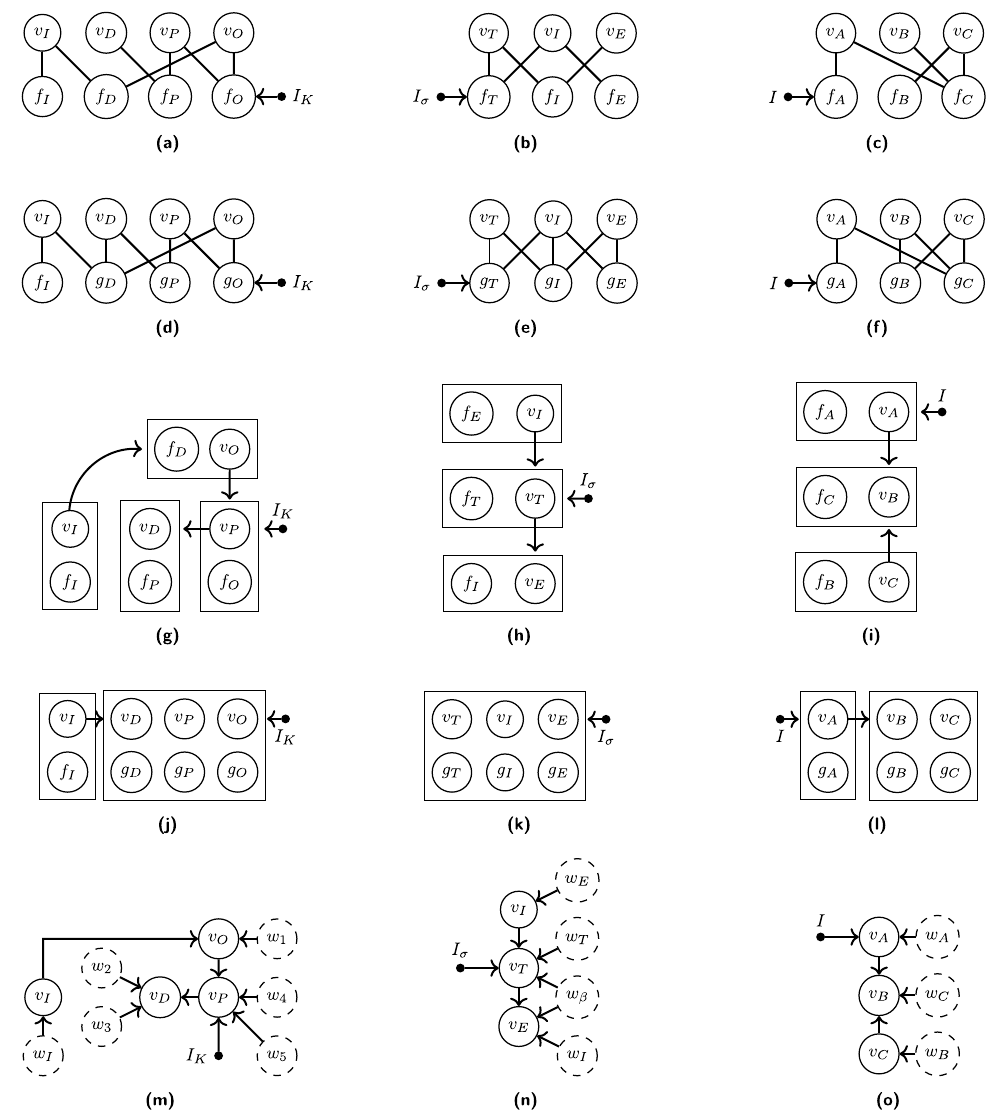
Figure 5: Graphical representations of the bathtub model ( left column ) , the viral infection model ( center column ) , and the reaction network with negative feedback ( right column ) . The input vertices I K , I σ , and I are represented by black dots, while exogenous variables are indicated by dashed circles. For each model, the structure of the equilibrium equations can be read o ff from the equilibrium bipartite graphs in ( a ) – ( c ) . The structure of the fi rst - order di ff erential equations can be represented with the dynamic bipartite graphs in ( d ) – ( f ) . The equilibrium causal ordering graphs corresponding to the equilibrium bipartite graphs are given in ( g ) – ( i ) . Similarly, the dynamic causal ordering graphs corresponding to the dynamic bipartite graphs can be found in ( j ) – ( l ) . The equilibrium Markov ordering graphs for the equilibrium distribution of the models are given in ( m ) – ( o )